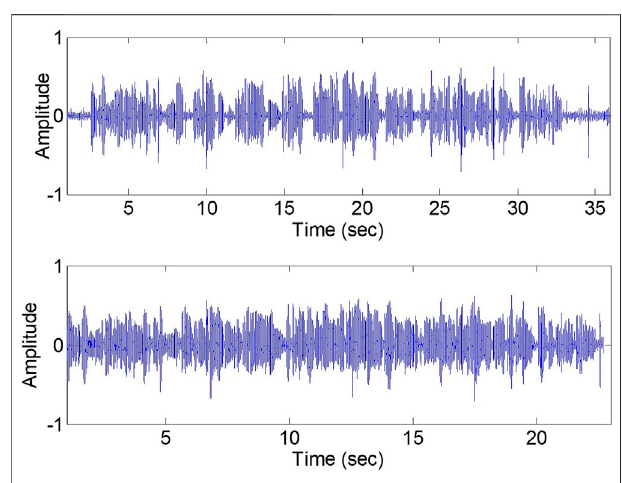
FIGURE 3 | Plot of sample speech segment before (upper) and after (lower) applying